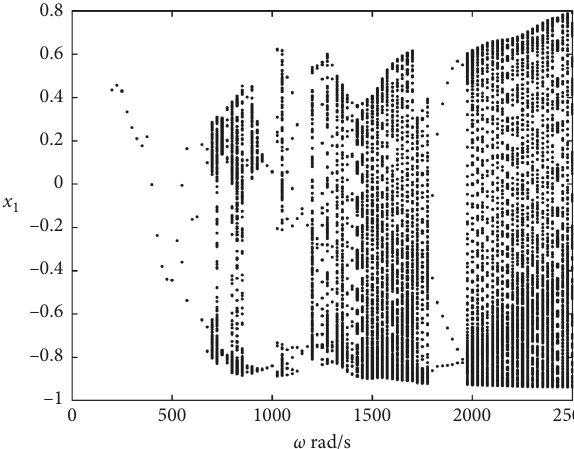
Figure 13: Bifurcation diagram of the rotor system in the x